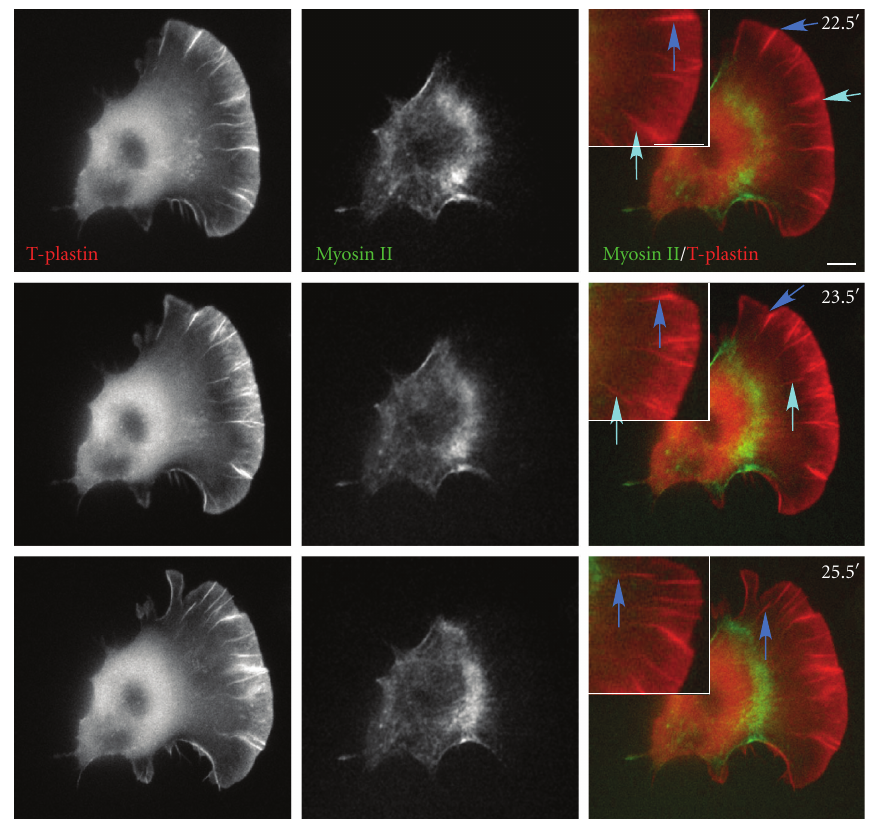
Figure 7: Stationary filopodia are not associated with myosin II. Live cell time-lapse images of a cell cotransfected with myosin II-GFP and mCherry-T-plastin. Arrows show two di ff erent thickened filopodia before or after being pulled out of the lamellipodial network. Most stationary filopodia disappeared in the transition zone and could not be tracked moving into the lamella. None of the filopodia showed obvious association with myosin II-GFP. The entire movie can be found in Supplementary Data, Movie 7. Scale Bar 10 μ m.